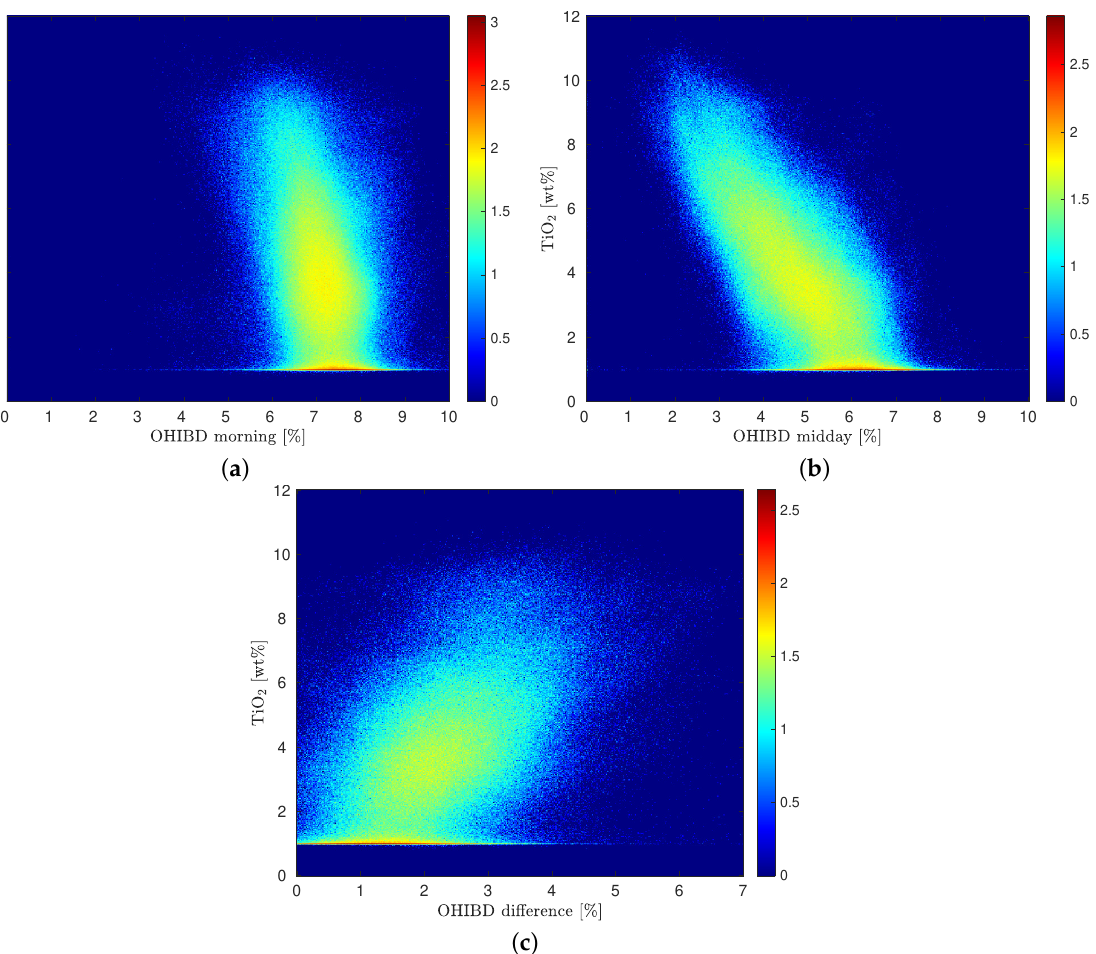
Figure 4. Density plots for TiO 2 abundance vs. morning OHIBD, midday OHIBD, and the difference between morning and midday OHIBD. The color bar represents the decadal logarithm of the number of examples at a discrete pixel in parameter space. ( a ) Morning OHIBD (r = − 0.30), ( b ) Midday OHIBD ( r = − 0.71), ( c ) OHIBD difference ( r =